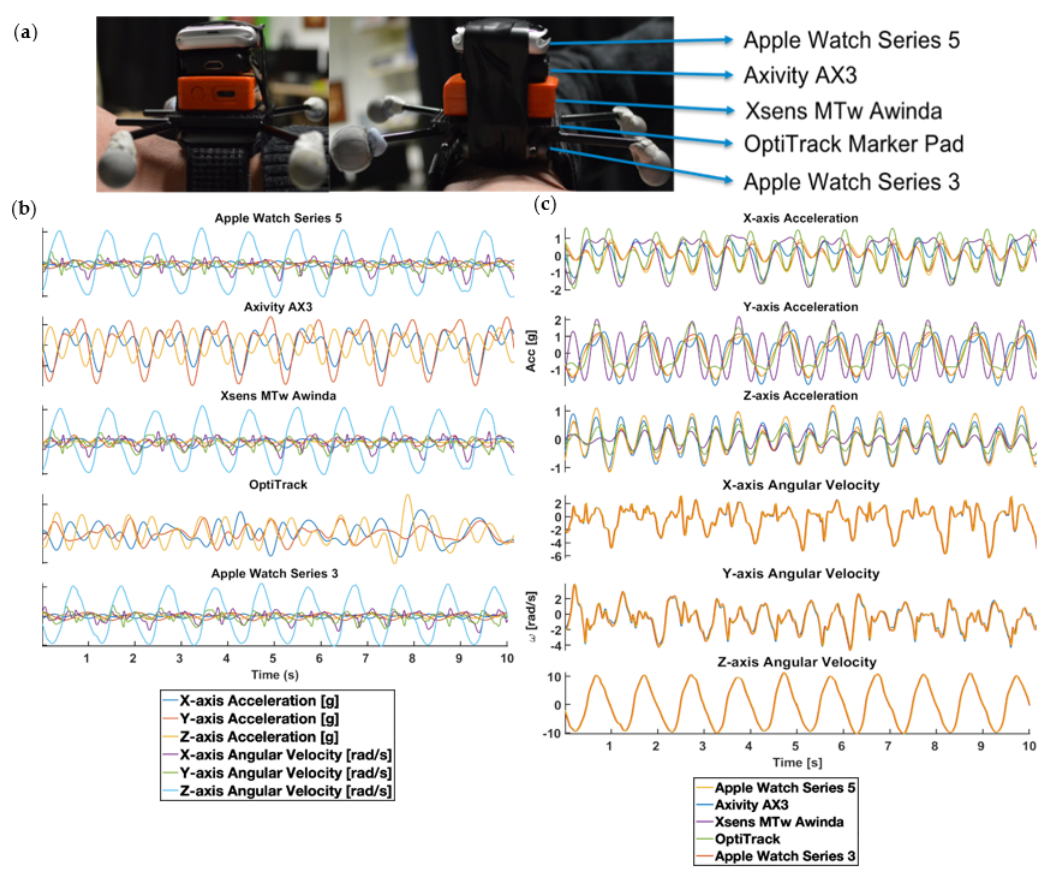
Figure 1. ( a ) depicts the participant wearing the sensor stack attached to the right wrist with the adjustable wrist strap. From top to bottom of the sensor stack, we mounted Apple Watches Series 5, Axivity AX3, Xsens MTw unit, OptiTrack retro-reflective marker pad with 4 retro-reflector unit (grey spheres), and Apple Watch Series 3 to one another vertically, aligning the centre of gravity, using Velcro sticky pads. ( b ) depicts 10-seconds sensors reading for each of the motion sensors. ( c ) shows 10-seconds sensors reading for each of the recording dimensions. The data depicted in ( b , c ) are sampled from one of the subject’s Composite Cross-Body Movement session and are both temporarily and spatially aligned.